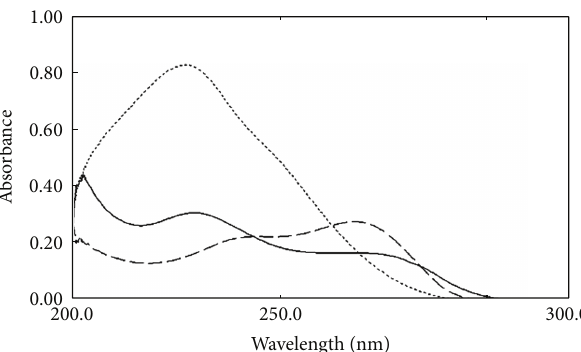
Figure 2: Zero-order absorption spectra of 10 𝜇 g mL −1 of CEF (—), 7-ACA (---), and 5-MER ( ...... .) using methanol as